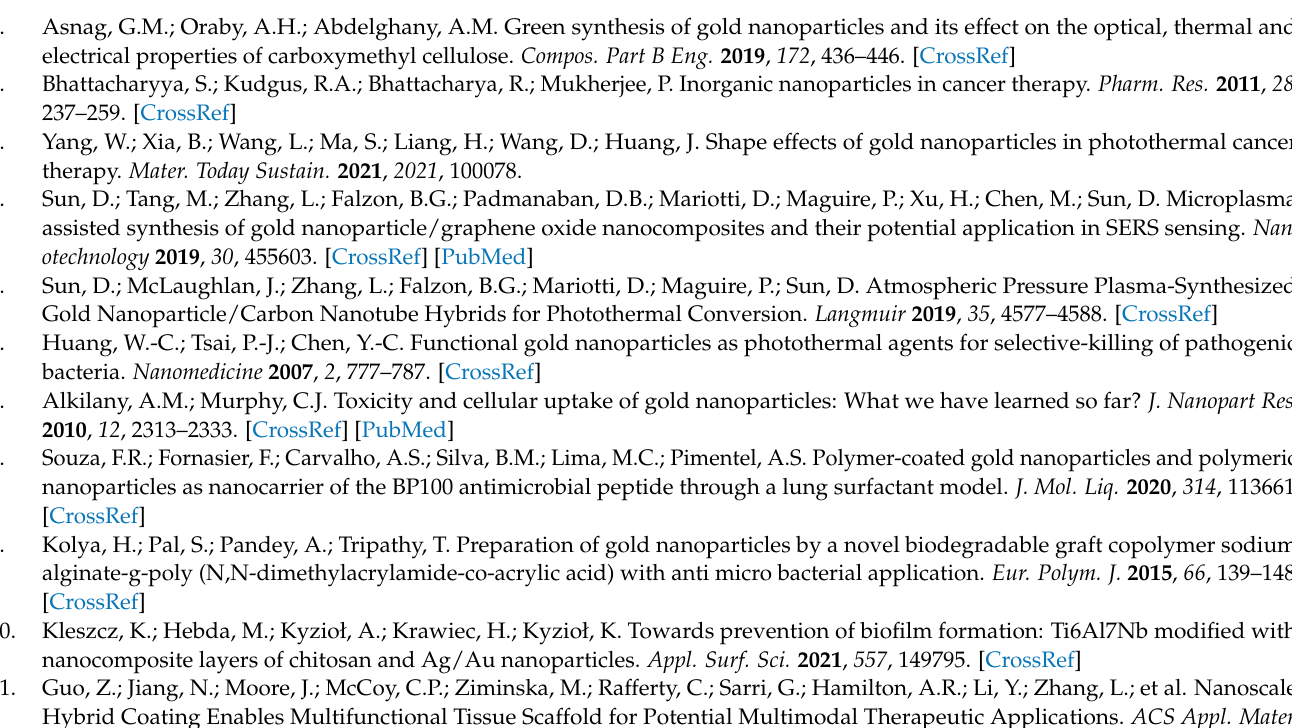
investigation, Figure S2: UV-vis spectra of 0.2 mM HAuCl 4 /m-CS mixture and untreated 0.2 mM HAuCl 4 in water, Figure S3: FTIR spectra of (a) untreated m-CS and APM-treated 0.1 mM